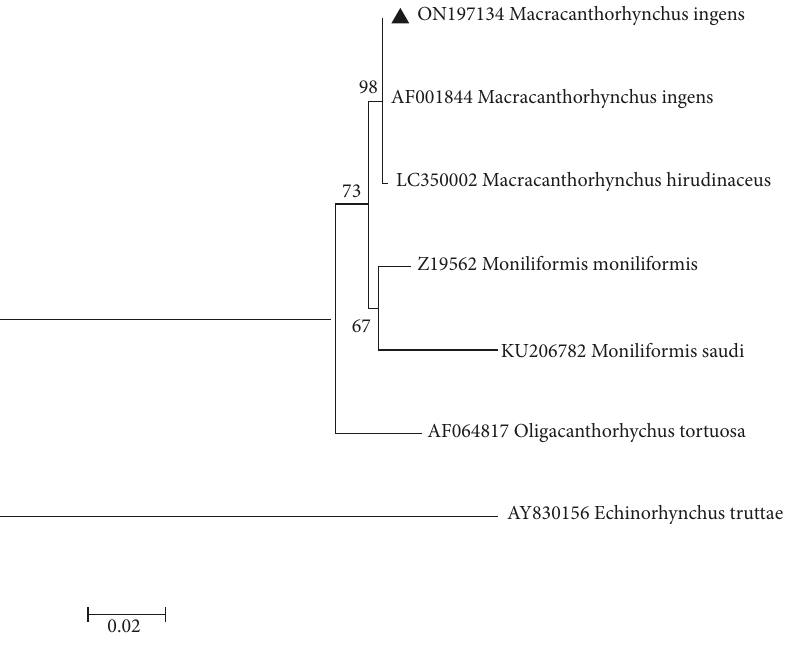
Figure 4: Phylogenetic analysis of isolate of M. ingens obtained in this study ( ▲ ) and closest-related members of class Archiacanthocephala retrieved from GenBank based on partial 18sRNA gene. Echinorhynchustruttae sequence was used as the out-group. The scale bar indicates the expected number of substitutions per